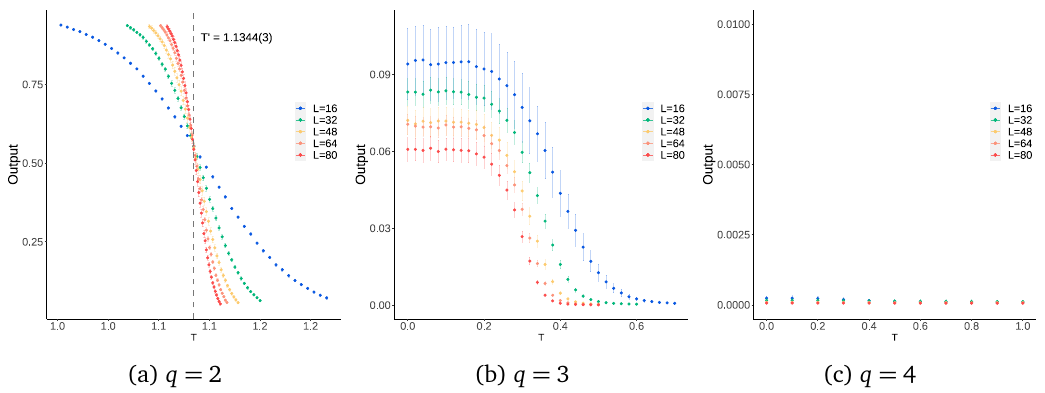
Figure 11: The relationship between temperature and the average output of an en- semble of 10 independently trained ANNs – training with MC data of the antifer- romagnetic square-lattice Ising model, and testing with MC data of the antiferro- magnetic q -state Potts model on a square lattice. The error bars shown are 99.7% confidence intervals of the ensemble